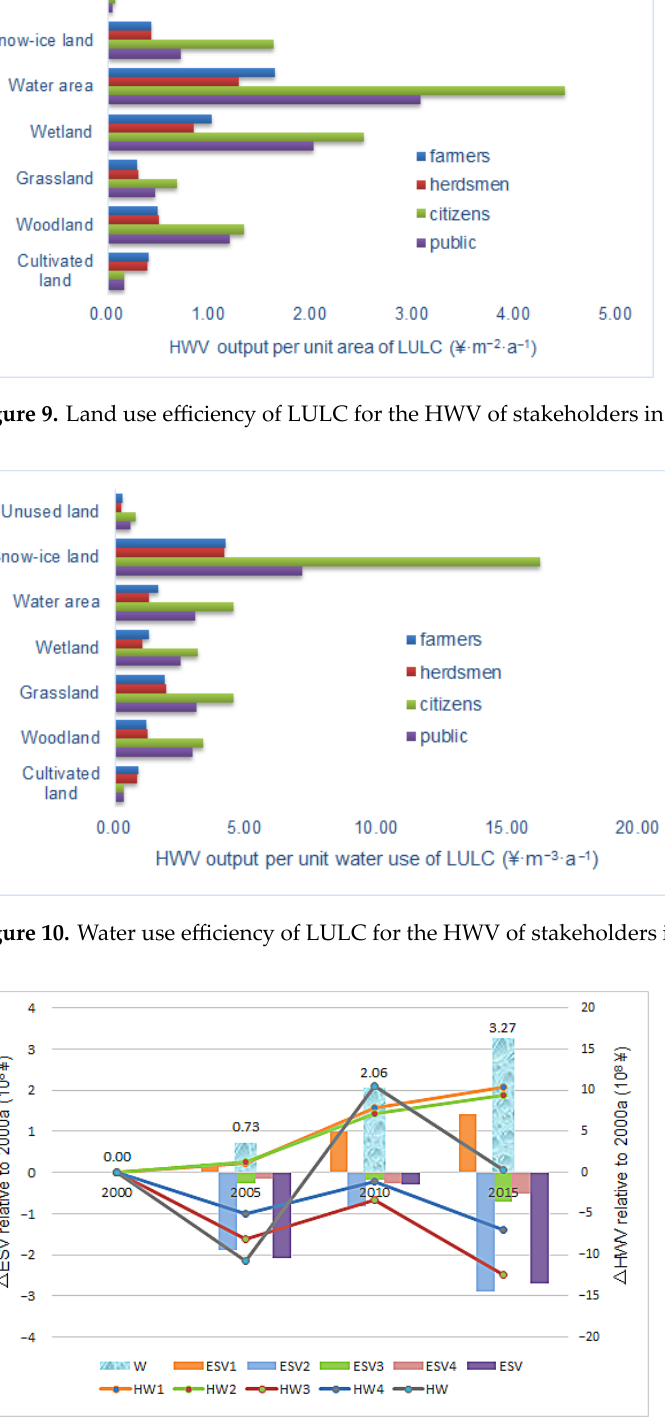
Figure 11. Relative annual dynamics of ESV-HWV-W in the basin from 2000 to 2015. Note: W is the water consumption amount (10 8 m 3 ); ESV1 – 4 are the ecosystem service values of supply, regu- water consumption amount (10 8 m 3 ); ESV1–4 are the ecosystem service values of supply, regulation, lation, support and culture (10 8 ¥); and HWV1 – 4 are the human well-being values of farmers, support and culture (10 8 ¥); and HWV1–4 are the human well‑being values of farmers, herdsmen, herdsmen, citizens and the public (10 8 ¥). citizens and the public (10 8